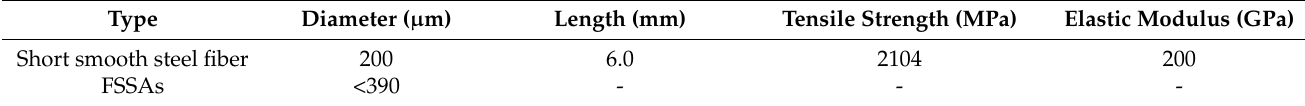
Table 4. Properties of functional fillers.